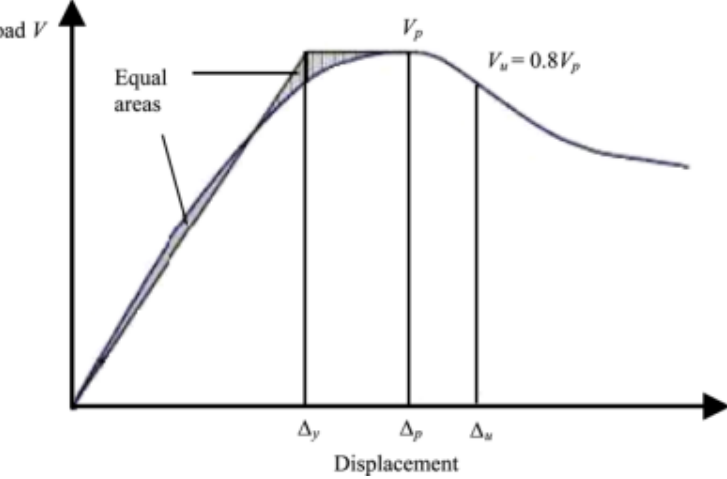
Figure 7. Definition of the ductility ratio. Table 4. Ductility of the tested specimens